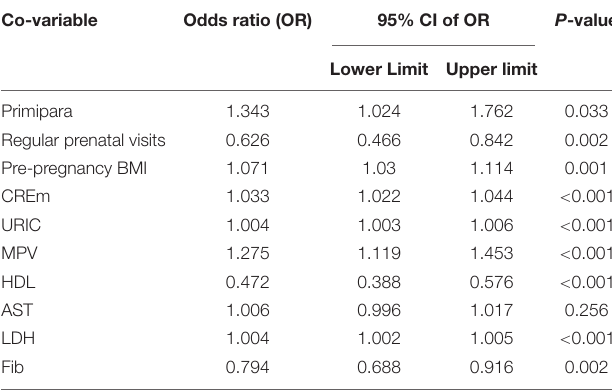
TABLE 3 | Multivariate logistic regression analysis of variables to identify factors predictive of preeclampsia in twin pregnancies. Co-variable Odds ratio (OR) 95% CI of OR P -value Lower Limit Upper